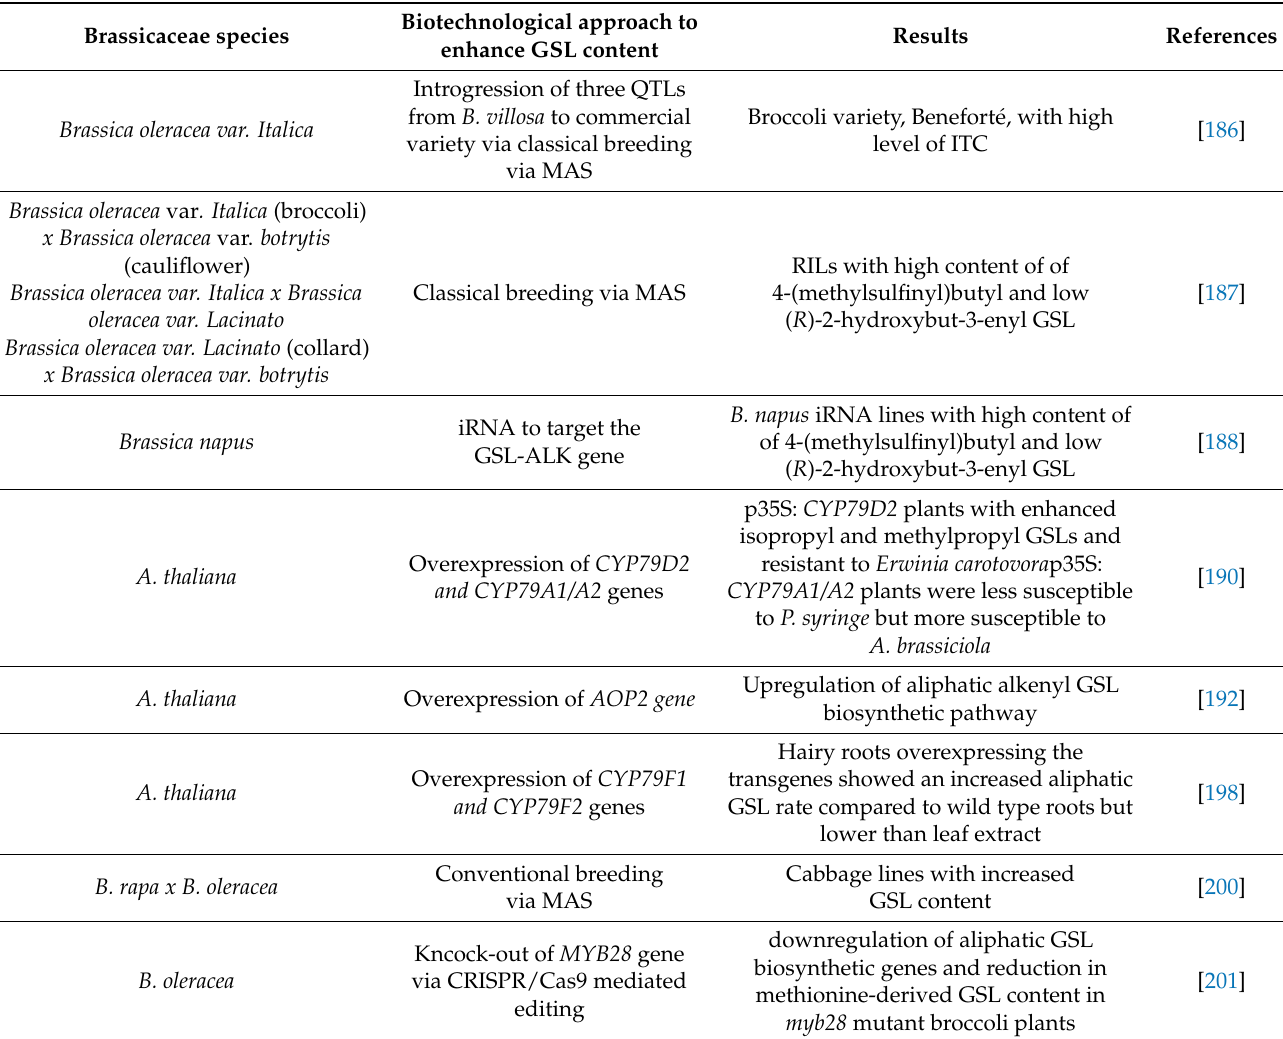
Table 3. Biotechnological approaches to enhance glucosinolate (GSL)